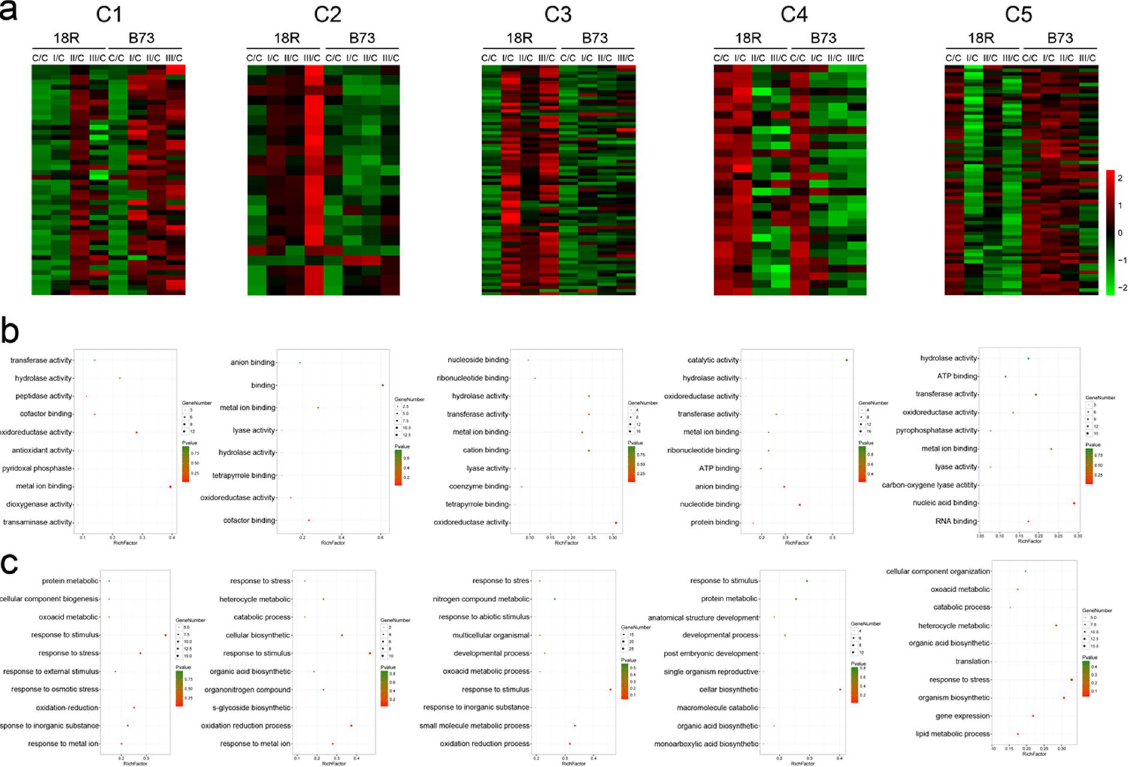
Figure 3. Cluster information. ( a ) Heatmap of the differentially expressed proteins (DEPs) between 18R and B73 in each cluster. ( b ) The top ten GO terms of molecular function of each cluster. ( c ) The top ten GO terms of biological process terms of each